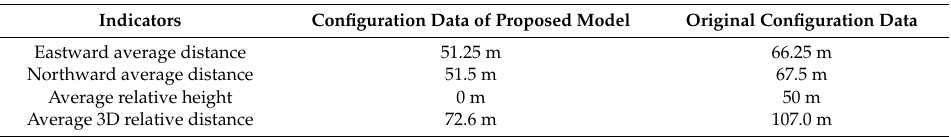
Table 2. The data of configurations with and without USCC stochastic system